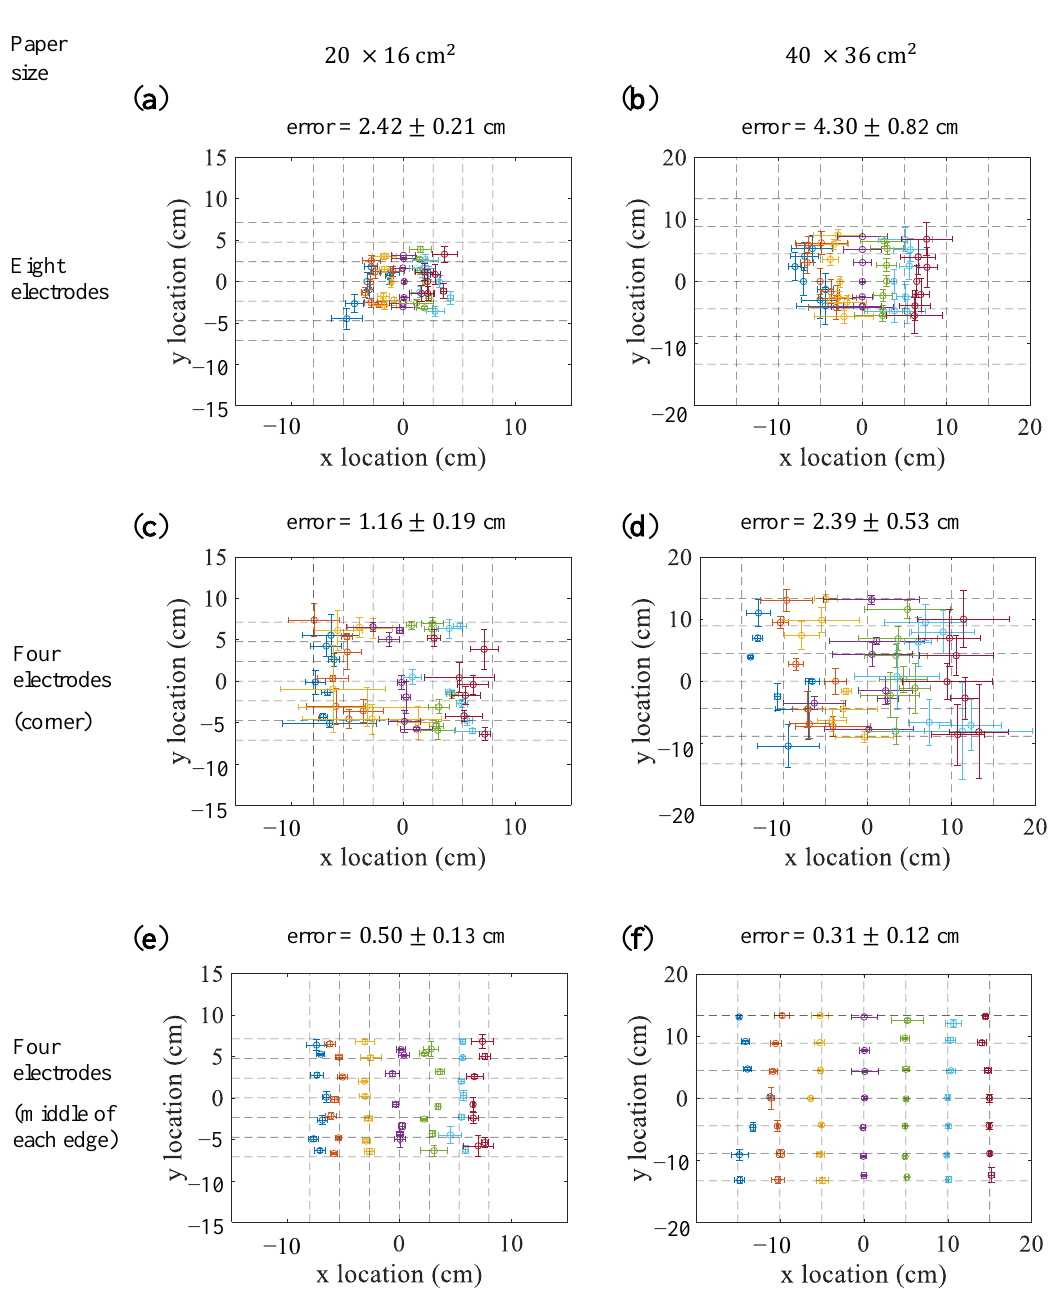
Figure 7. Results of the differential output methods. ( a , c , e ) show the results for the 20 × 16 cm 2 paper. ( b , d , f ) show the results for the 40 × 36 cm 2 paper. ( a , b ) show the results obtained using eight electrodes. ( c , d ) show the results obtained using four electrodes placed in the corners of the paper. ( e , f ) show the results obtained using four electrodes placed in the middle of the edges of the paper. The points denote the mean estimated locations for the intersection points, and the error bars denote the standard